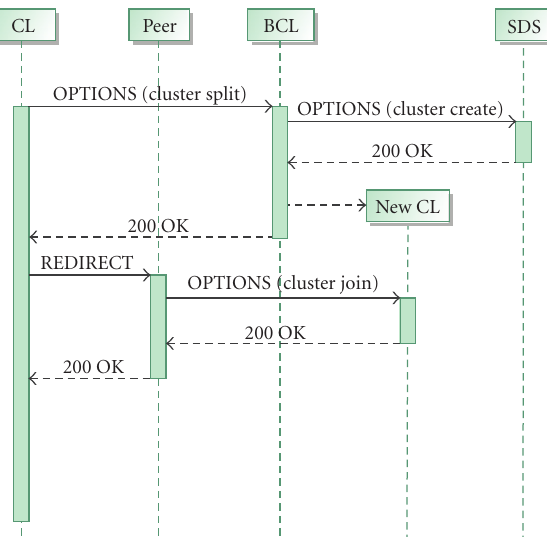
Figure 4: Successful cluster splitting procedure.